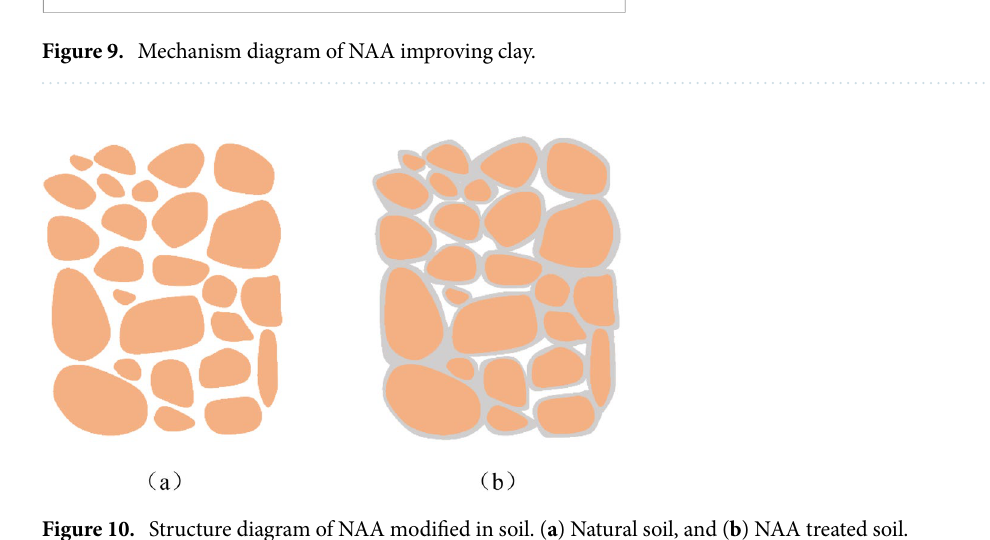
Figure 10. Structure diagram of NAA modified in soil. ( a ) Natural soil, and ( b ) NAA treated